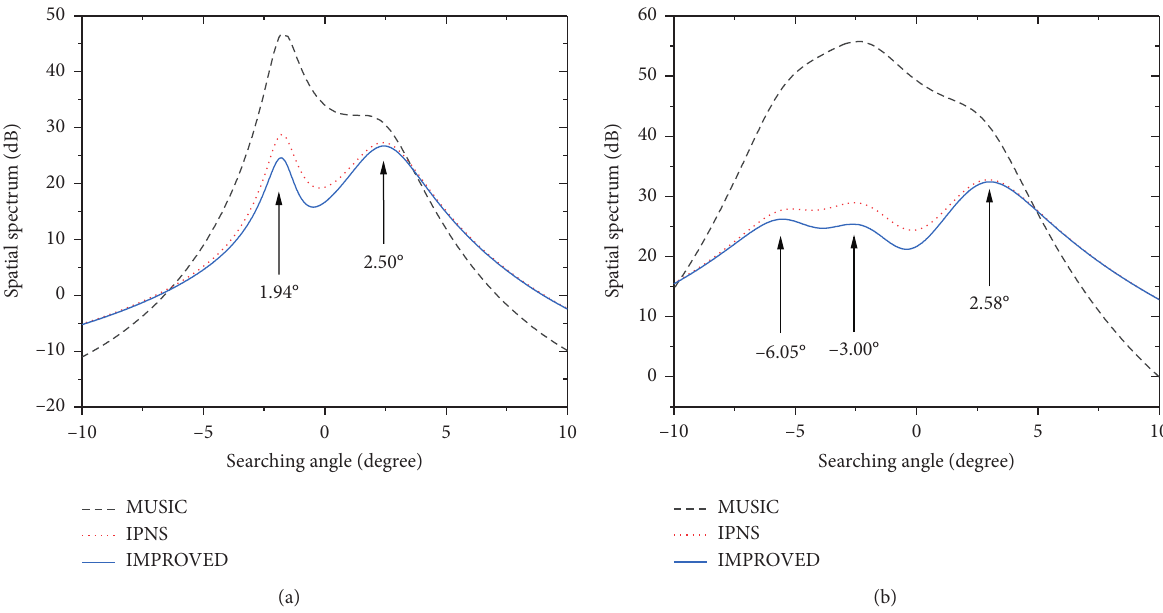
Figure 7: The spatial spectra of different methods. (a) Two sources from ± 2 ° with SNR 2 ° and 6 ° with SNR 1 � 17dB, SNR 2 � 7 and SNR 3 � 12.